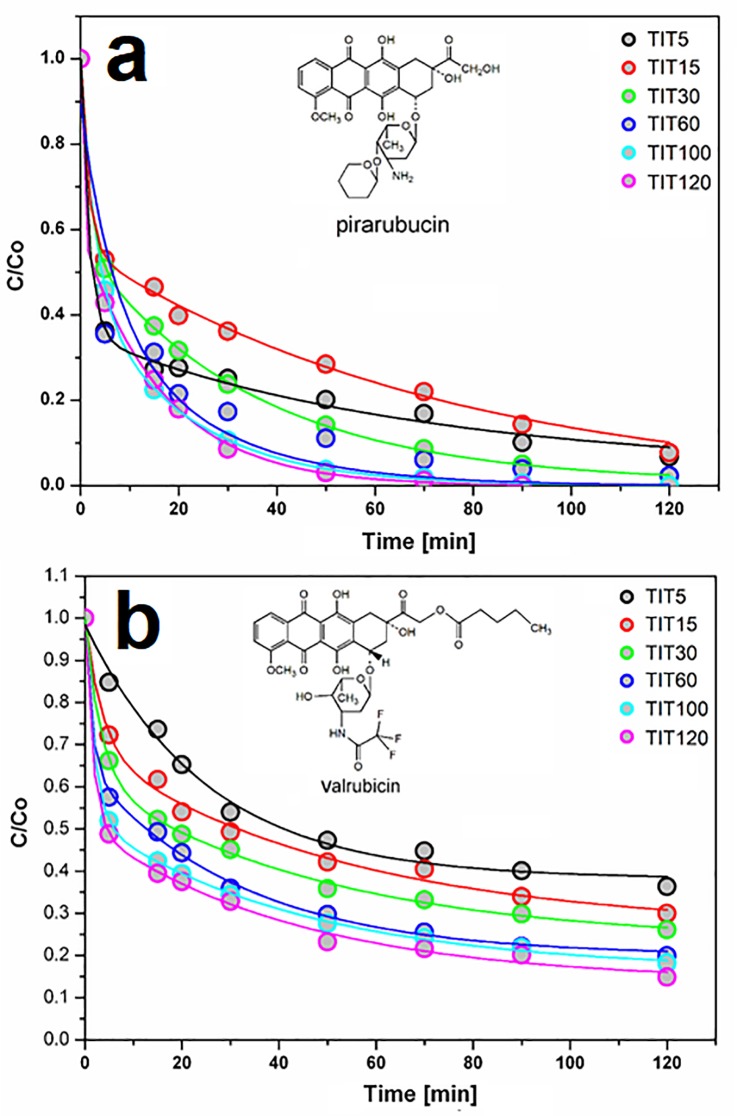
Normalized kinetic curves of pirarubicin (a) and valrubicin (b) adsorption on TiO2 samples differing in TiOSO4.